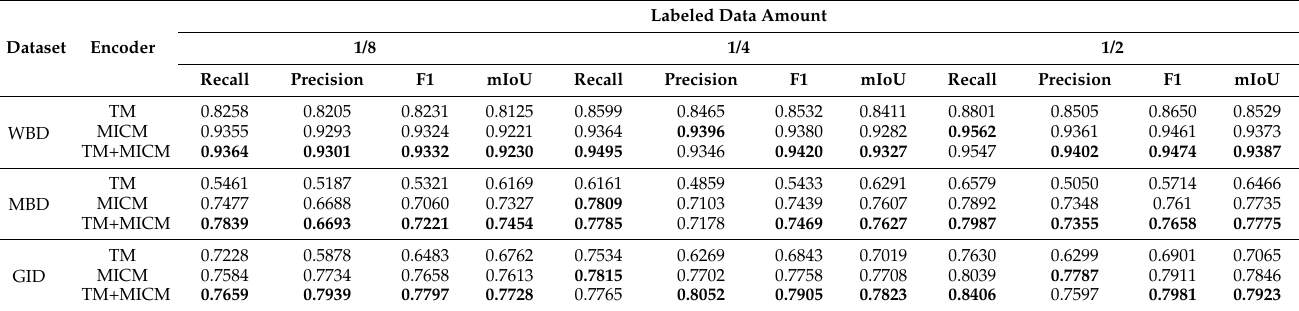
Table 5. Building extraction accuracies with single/double-branch encoders. The highest accuracy is displayed in bold.